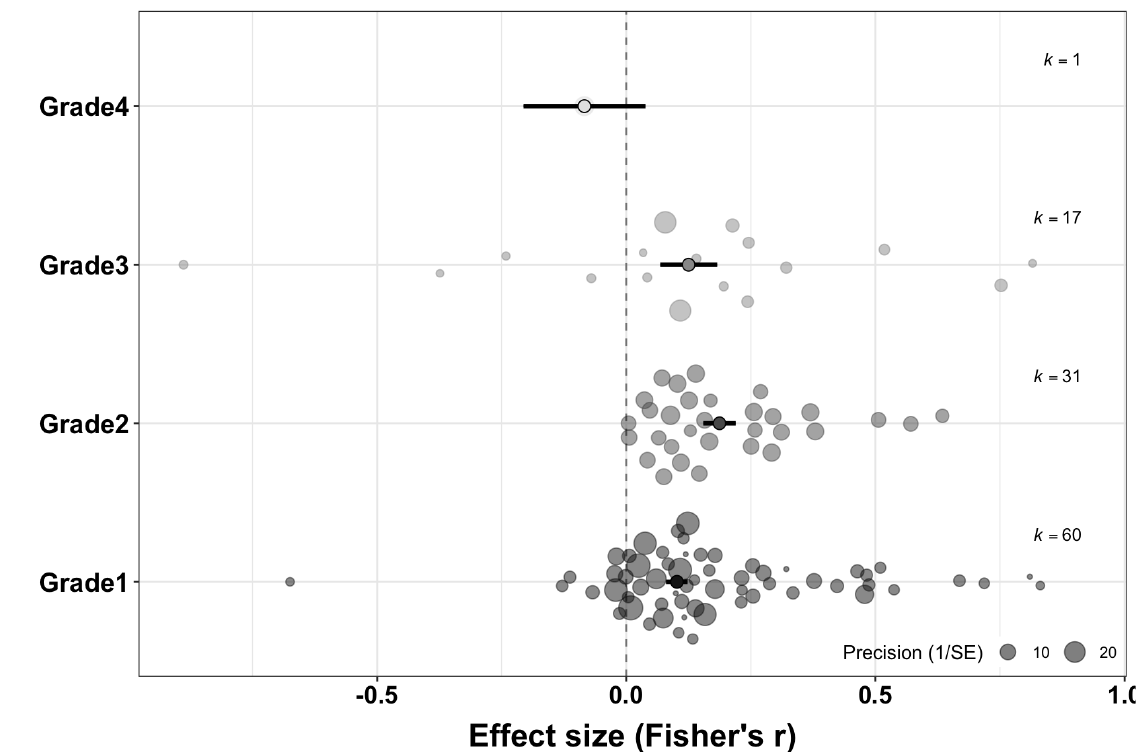
Figure 7. The effect of dominance rank on female reproductive success is similar across macaque species with different dominance styles. Relationships among female group members in species of grade 1 (bottom dark grey) are generally considered egalitarian, while grade 4 (top light grey) is assigned to species in which relationships are deemed highly despotic. Species with different dominance styles are not estimated to be different (all posterior contrasts overlap